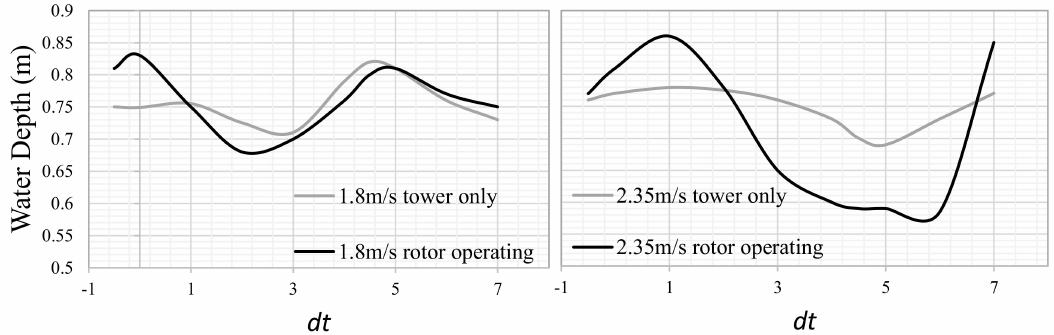
Figure 1. Water surface profile through a scaled turbine operating at 2 different velocities, compared to the no-energy-extraction stage